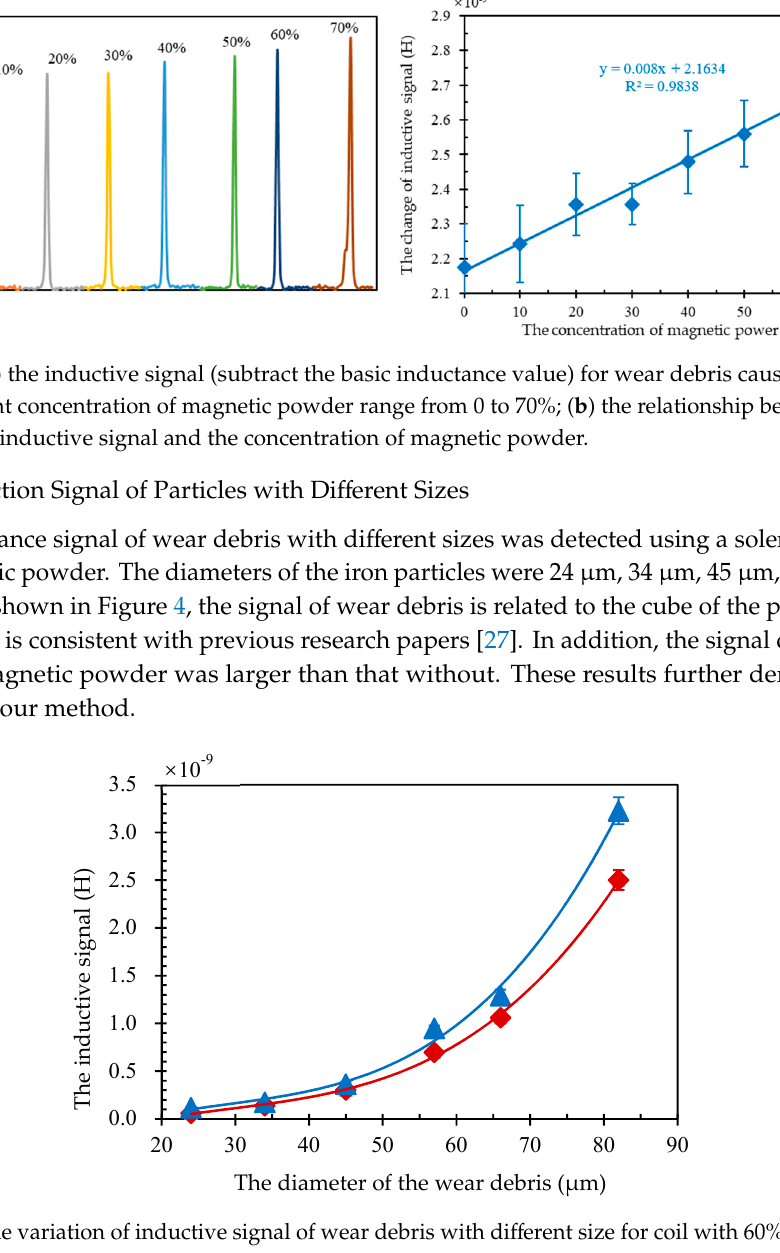
Figure 3. ( a ) the inductive signal (subtract the basic inductance value) for wear debris caused by coil with different concentration of magnetic powder range from 0 to 70%; ( b ) the relationship between the variation of inductive signal and the concentration of magnetic powder.